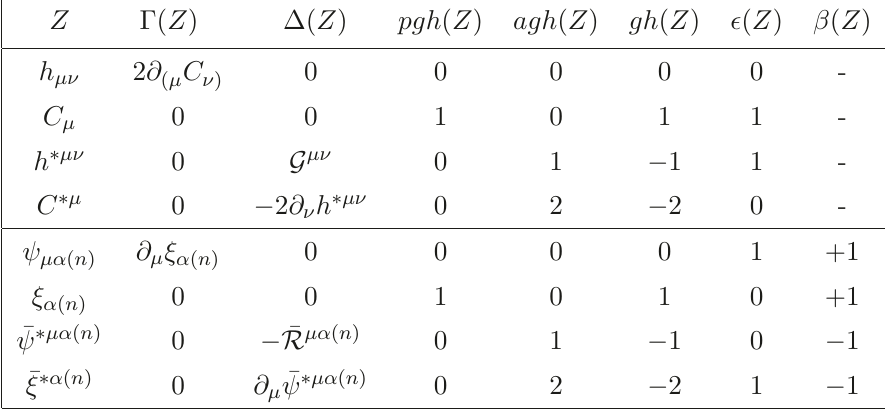
Table 2 . Properties of the Fields & Antifields ( s = n + 3 /